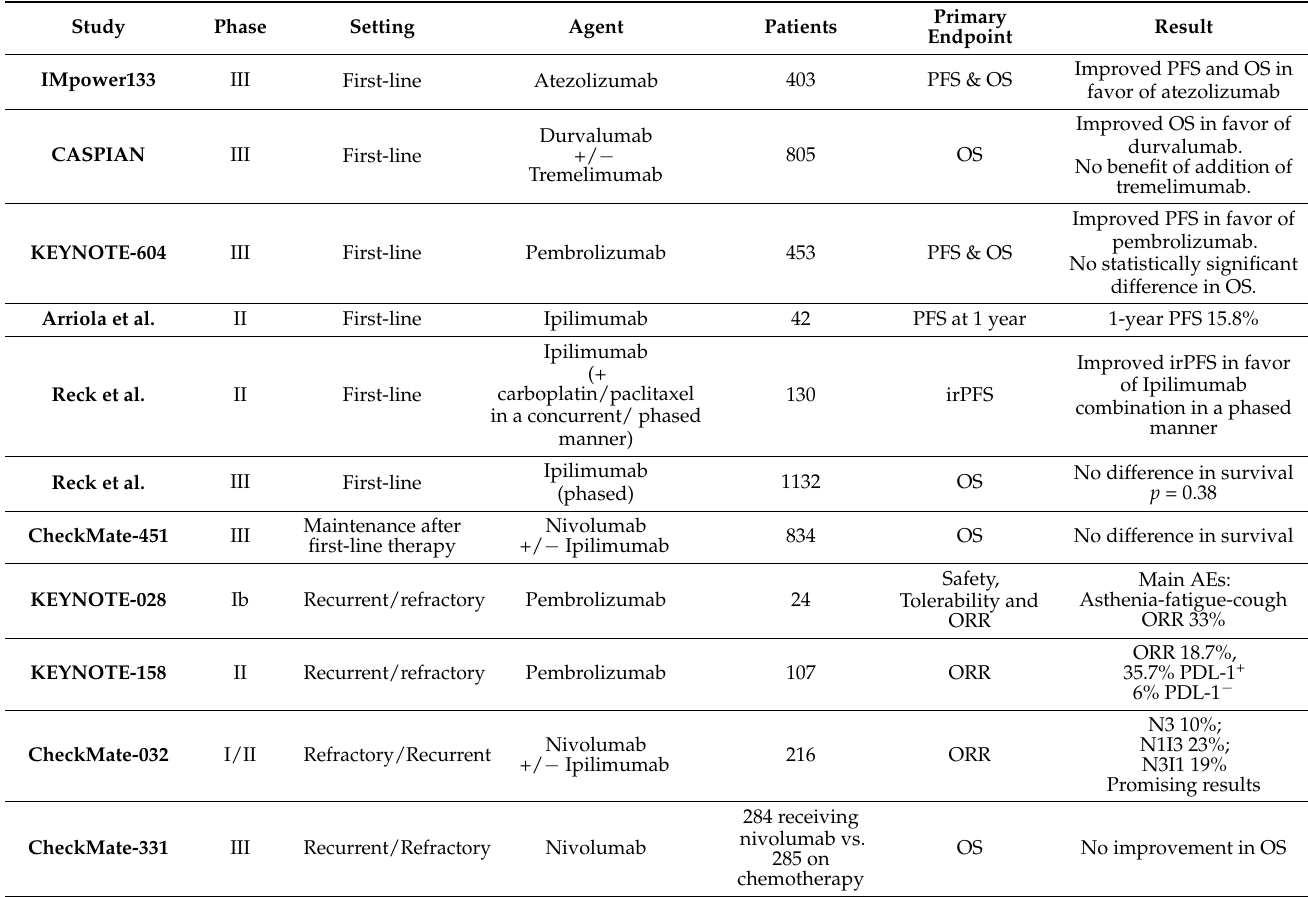
Table 2. Pertinent Studies of Immunotherapy in